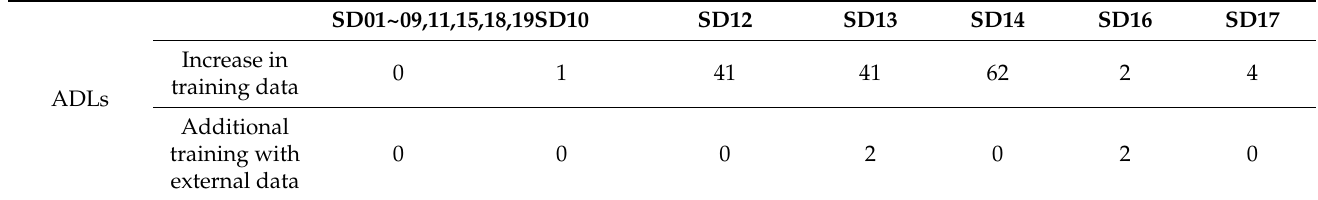
Table 5. False alarms of ADLs in the external test with ANN and SWF.